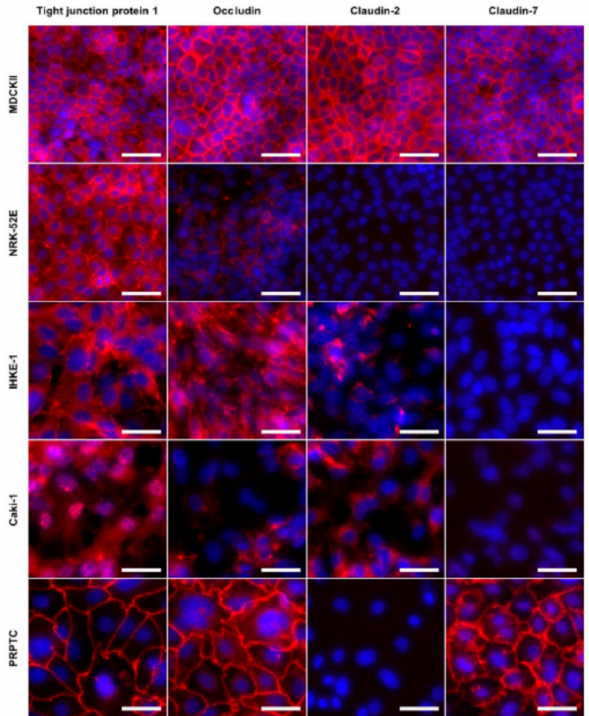
Figure 7. Expression of the tight junction proteins tight junction protein 1, occludin, claudin-2 and claudin-7 in the renal cell lines MDCKII, NRK-52E, IHKE-1 and Caki-1, and in cultured PRPTCs. All cells were cultured on chambered glass slides for 5 days under standard conditions. For immunoflu- orescent staining, cells were incubated with primary and Cy3-conjugated secondary antibodies (red) and DAPI (blue). Negative controls incubated only with secondary antibodies showed no staining (not shown). Scale bars = 100 µ